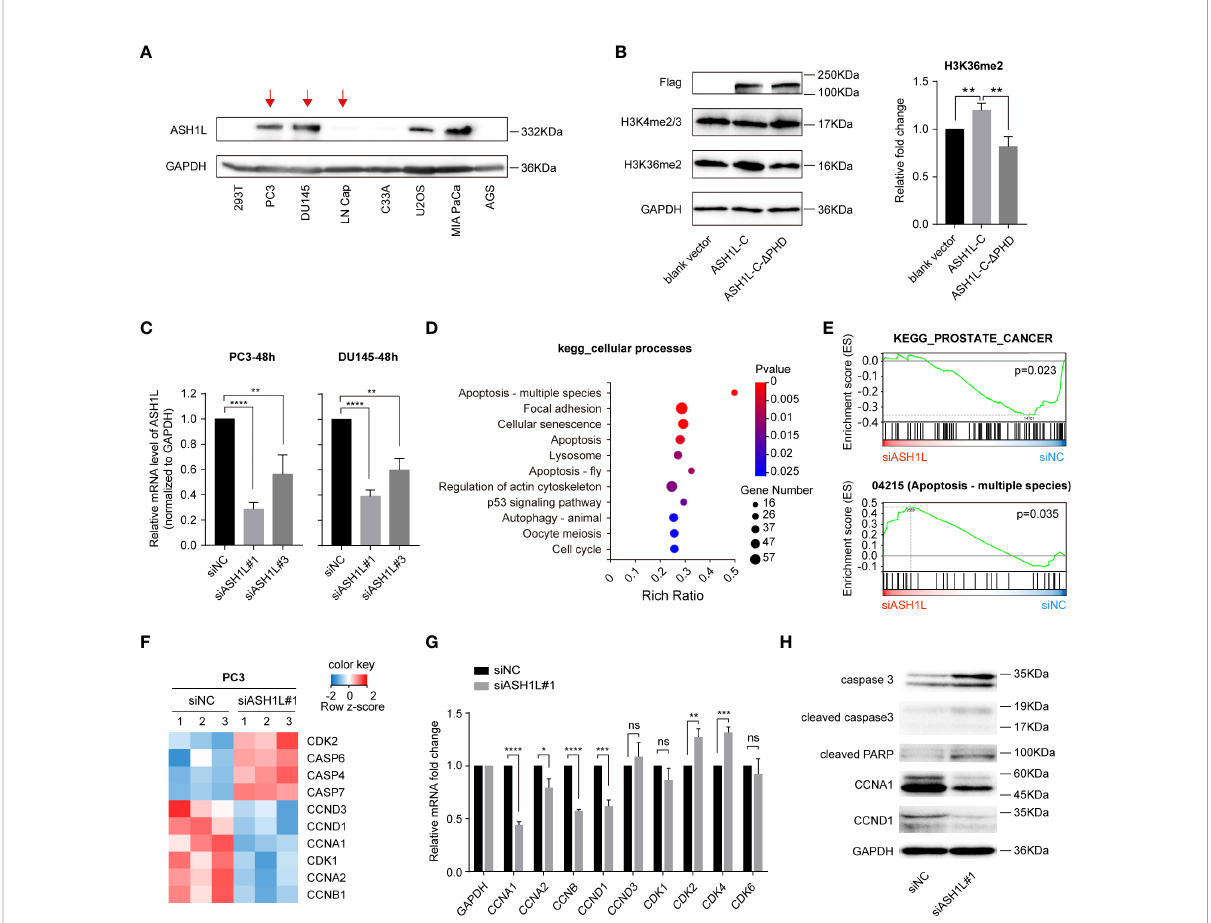
FIGURE 4 ASH1L is required for gene expression regulation in the cell cycle and apoptosis. (A) Western blot analysis of ASH1L protein levels in different cancer cell lines. The GAPDH was used as a loading control. (B) Western blot analysis of H3K4me2/3 and H3K36me2 levels